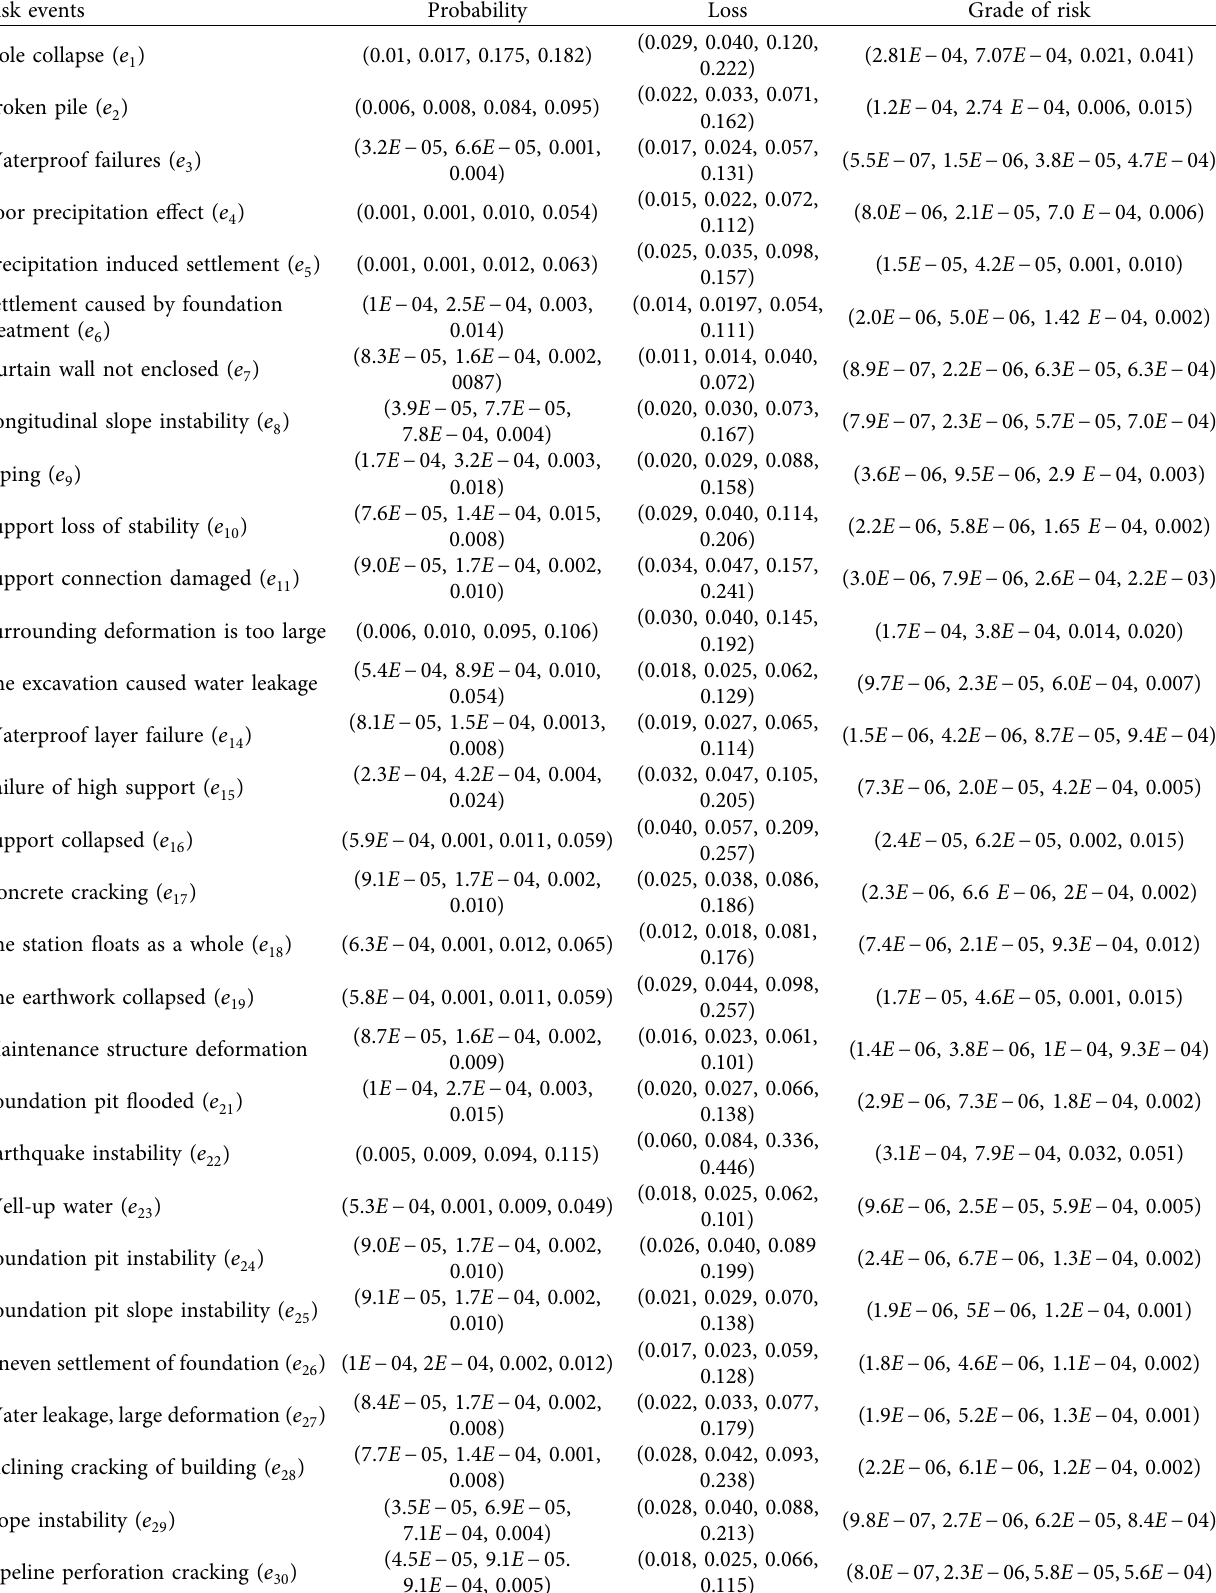
Table 14: List of possibility, loss, and risk grade of all risk events in metro deep foundation